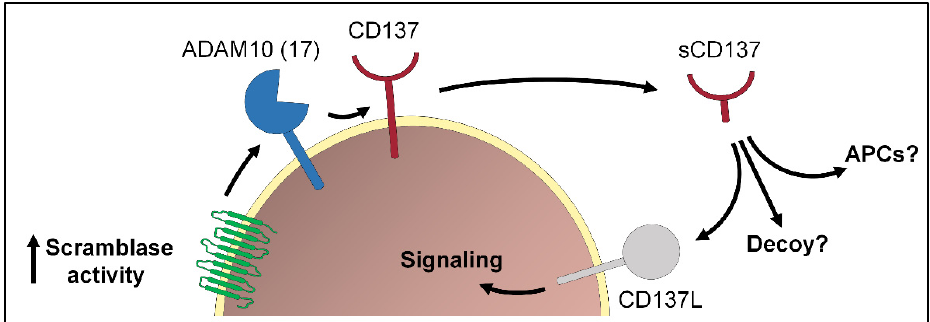
Figure 2. Transient exposure of PS plays an important role in the immune system. One example is the release of the TNFR family member CD137 via ADAM10 (or ADAM17 ). Soluble CD137 (sCD137) can bind to its ligand CD137L expressed on activated T cells and activate cell signaling. Whether sCD137 could fulfill additional functions, e.g., activation of antigen-presenting cells (APCs) or act as decoy is still not clear.